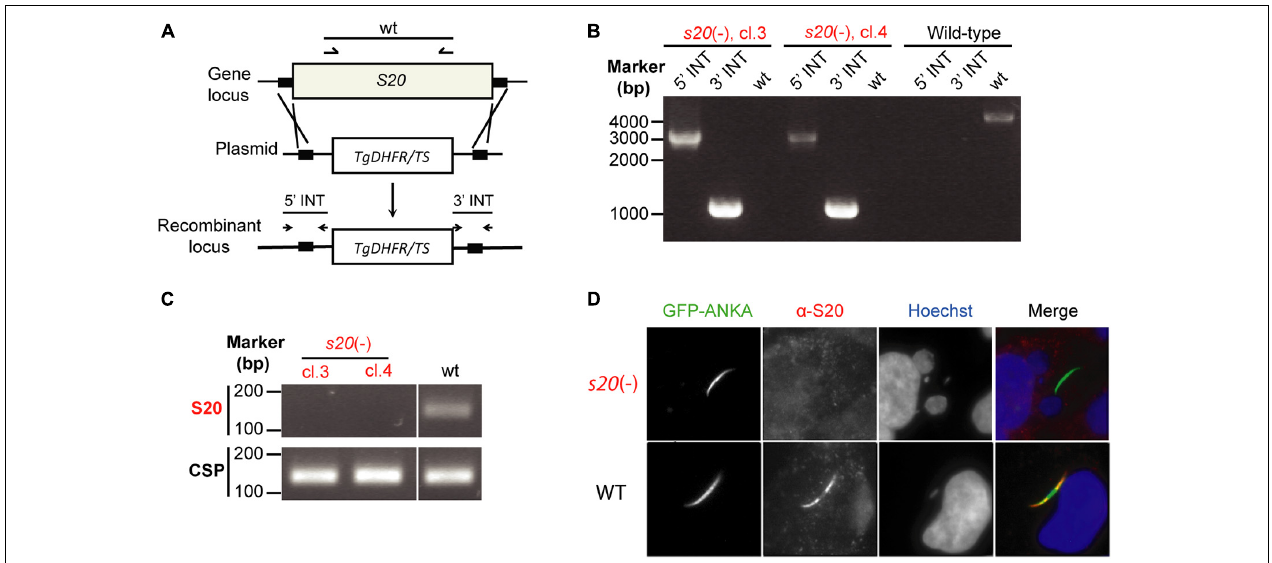
FIGURE 2 | Targeted gene deletion of P. berghei S20 . (A) Schematic diagram of the replacement strategy to generate s20 (-) parasites. After linearization with Sac II and Kpn I, the replacement vector containing portions of the 5 (cid:48) and 3 (cid:48) flanking regions of S20 coding sequence and the Toxoplasma gondii dihydrofolate reductase/thymidylate synthase (Tgdhfr/ts) selectable marker was transfected into P. berghei ANKA wild-type parasites. (B) Diagnostic PCR to confirm successful replacement of the S20 genomic locus with the positive selection marker in s20 (-) parasites. Shown are the results from clone 3 and 4. 5 (cid:48) - and 3 (cid:48) -integration-specific primer combinations (5 (cid:48) INT and 3 (cid:48) INT) amplify the predicted fragment only in the recombinant locus. Wild-type-specific primer pairs (wt) do not produce a PCR fragment in the recombinant locus confirming absence of residual WT parasites. (C) Verification of absence of S20 transcripts in s20 (-) clones 3 and 4 salivary gland sporozoites by RT-PCR. Note that s20 mRNA (top) is only detectable in WT sporozoites. CSP mRNA (bottom) serves as positive control. (D) Indirect immunofluorescent stainings of permeabilized infected hepatoma cells 1 h after s20 (-) (top) or WT (bottom) sporozoite addition. Stainings were done with anti-GFP antibody, an anti- Pb S20 serum, and corresponding secondary antibodies. Shown are immune stainings, DNA stains (Hoechst, blue) and merge